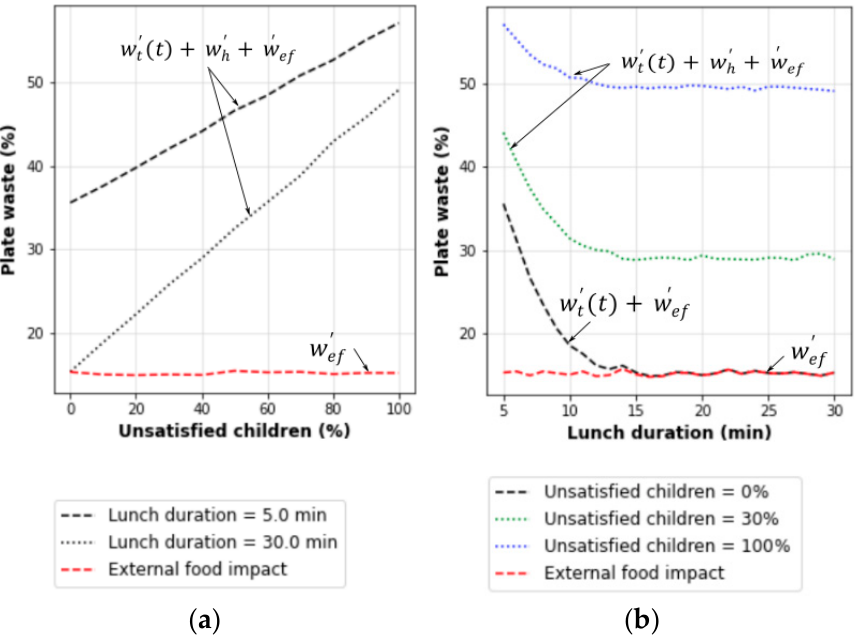
Figure 9. Tomograms of the simulation results: ( a ) depict the impact of rejected food on plate waste; ( b ) depict the impact of lunch duration on plate waste.